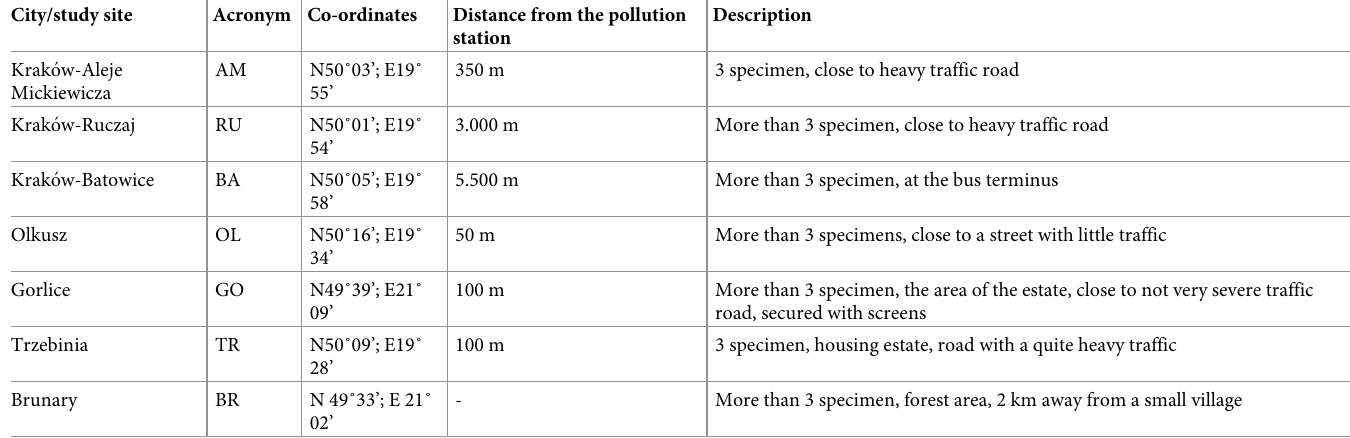
Table 1. Information on the study sites, including geographical location, distance from the pollution monitoring station and short description on habitat conditions. City/study